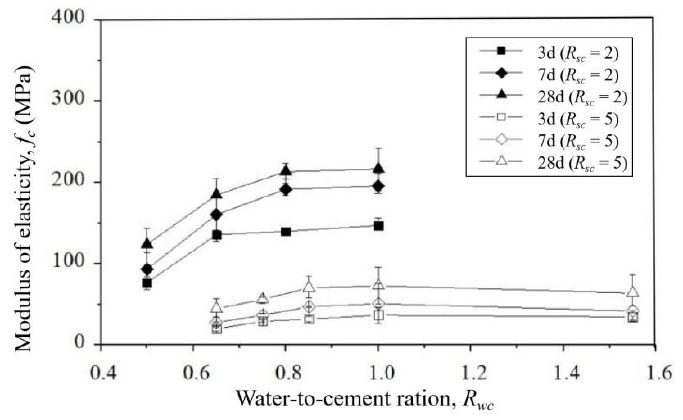
Figure 6. Relationship between modulus of elasticity and water-to-cement ratio ( R wc ).